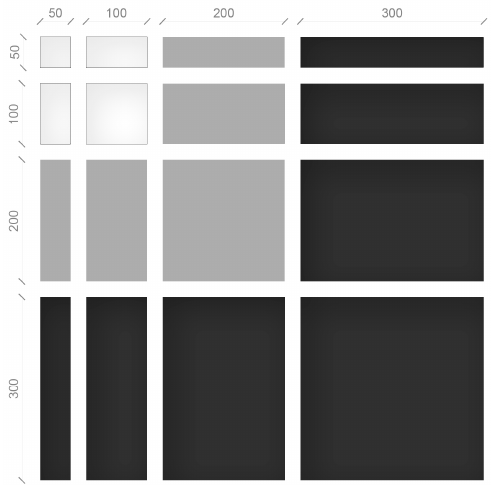
Figure 3. 2D modeling of the sub-module frames by decomposition. The basic module is shown in black 300 x 300 mm. Sub-modules with maximum base dimensions of 200 mm by 200 mm are shown in gray and those with maximum base dimensions of 100 mm by 100 mm are shown in white.